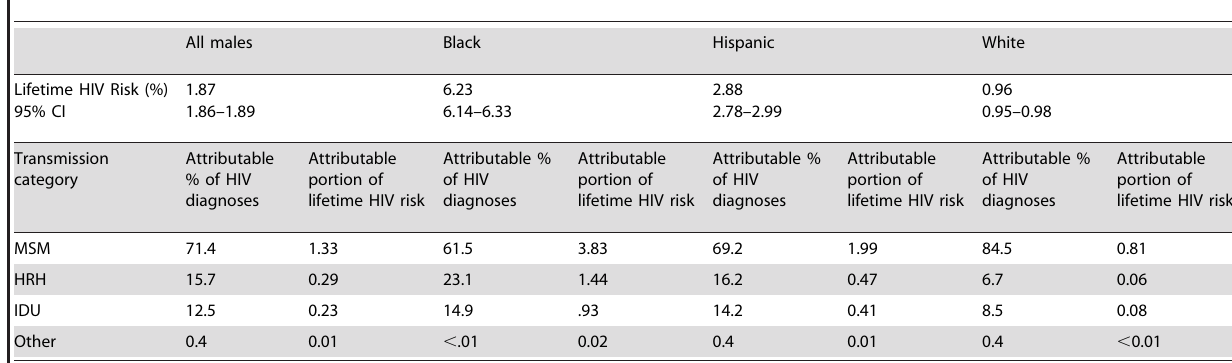
Table 2. U.S. males’ HIV lifetime risk by transmission category.